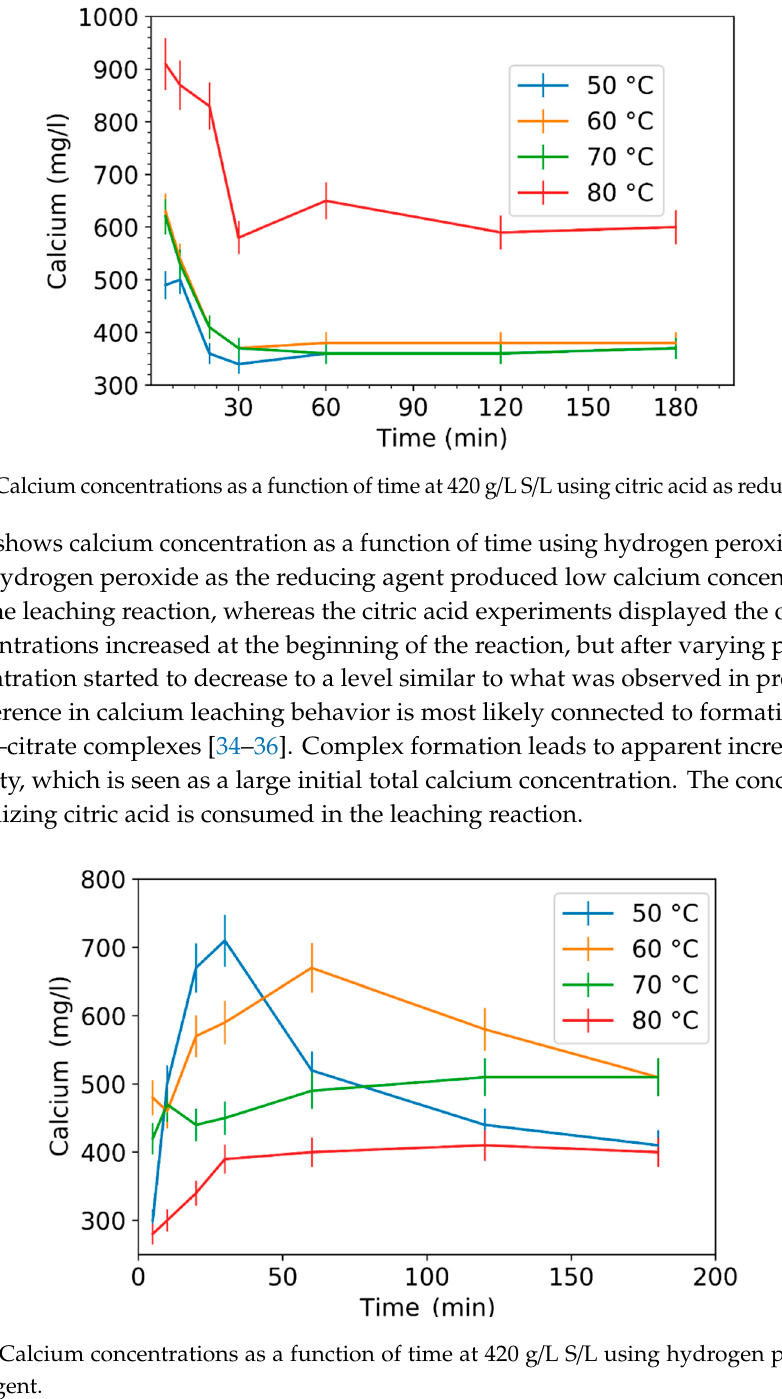
Table 3. Elemental analysis of the purity of leachates after reductive leaching.